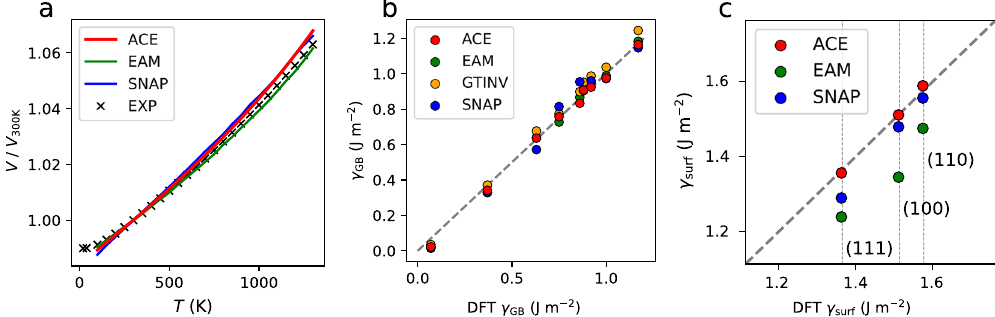
Fig. 4 Thermal expansion, grain boundary, and surface energies for Cu. a Thermal expansion for fcc, experimental data taken from ref. 61 . b Twin and twist GBs, energies with respect to DFT reference from Zheng et al. 38 . c Surface potentials and together with EAM agree best with recent DFT results 40 . The 〈 100 〉 dumbell is predicted to have the lowest energy, followed by the octahedral and tetrahedral con fi gurations.